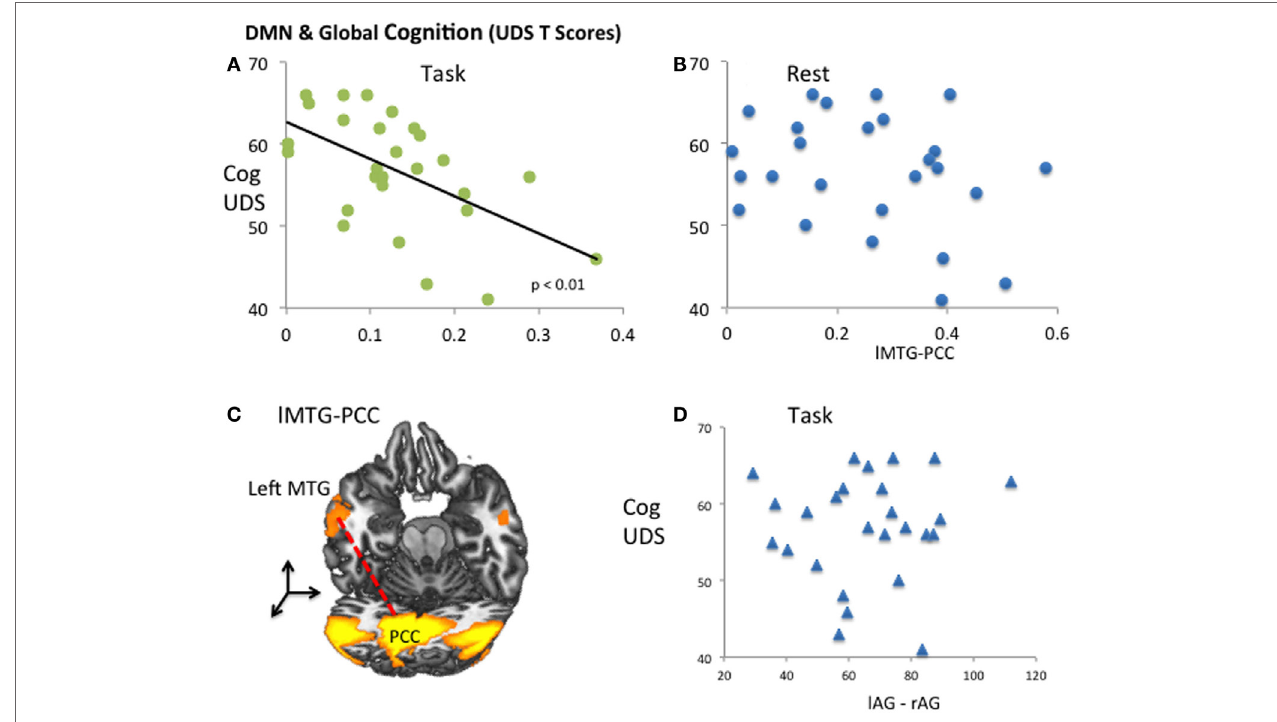
FigUre 4 | DMn and global cognition (UDs T -scores). (a) Significant correlation ( p < 0.01) was found during task between global cognitive scores and temporal–parietal (lMT–PCC) connectivity. (B) During resting state, no significant correlation was found between global cognitive scores and temporal–parietal connectivity. (c) . Group averaged fMRI activity at the left MT and PCC/precuneus. (D) . Bilateral IAG, correlated with pTau, was not correlated with global cognition.